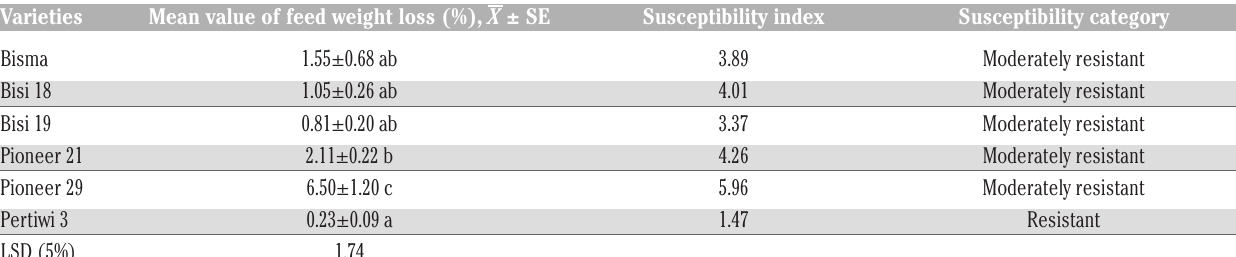
Table 4. Mean value of feed weight loss percentage (%) in six corn varieties caused by S. zeamai s attack, susceptibility index and cate- gory on tests using NCTM. Varieties